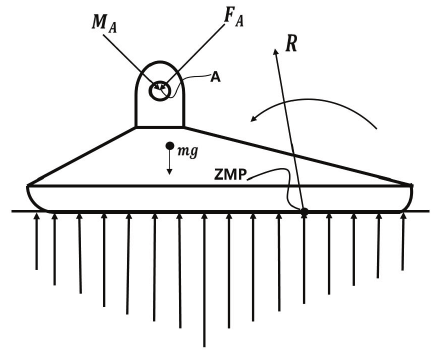
Figure 2. Forces acting on the supporting